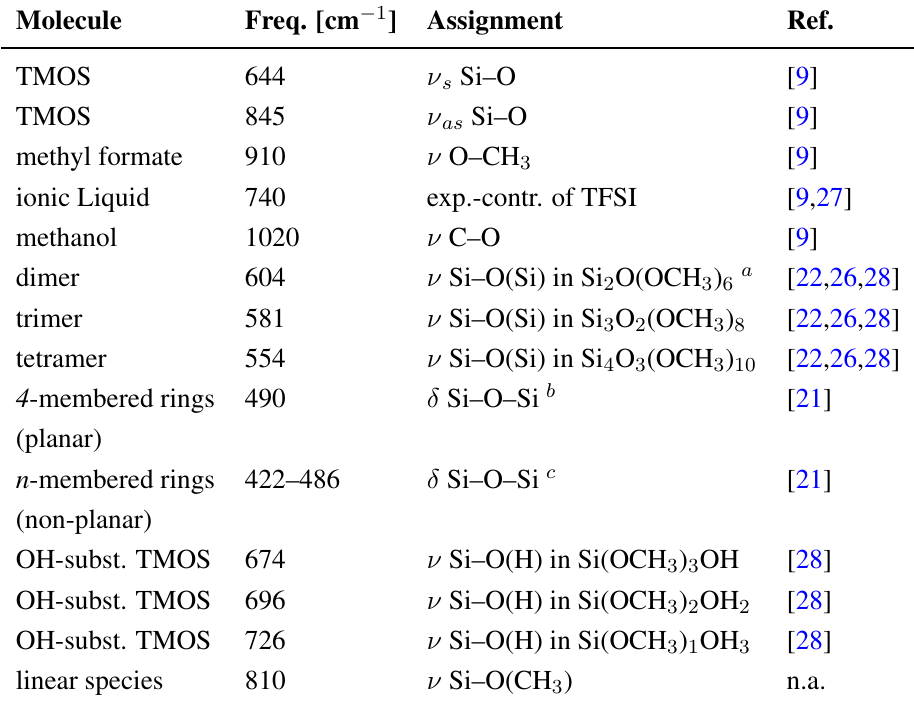
Table 1. Raman frequency shifts (in cm − 1 ) of different molecules and intermediates participating in the sol-gel reaction, together with reported or proposed assignments. Molecule Freq. [cm − 1 ] Assignment